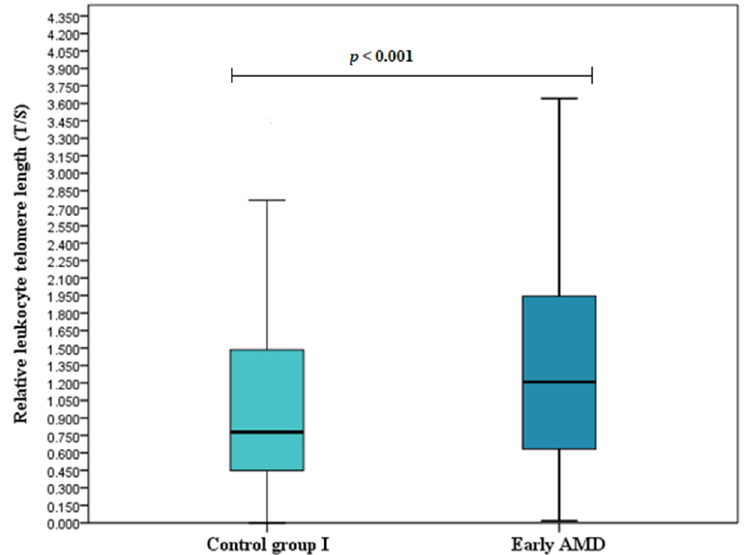
Figure 1. Relative leukocyte telomere length in early AMD patients and the control group I. Relative leukocyte telomere length (T/S) in early AMD patients versus healthy controls are presented as box-and-whisker plots with the median and IQR. Mann–Whitney U test was used to assess T/S differences between patients with early AMD and control groups; p < 0.001.